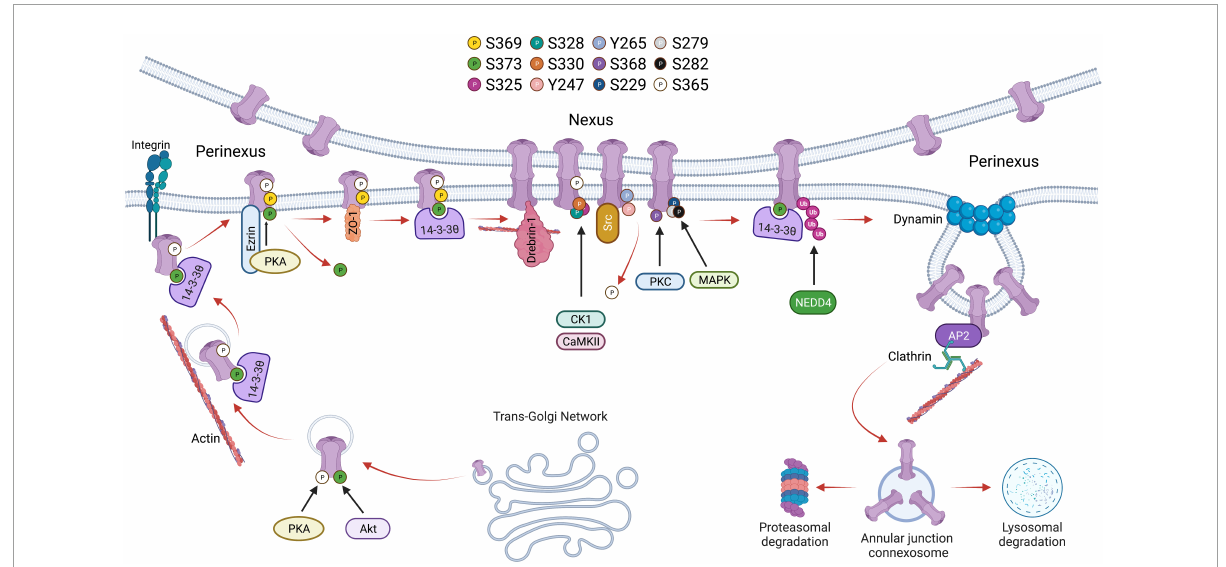
FIGURE1 Schematic showing the life cycle of Cx43 beginning from trafficking through trans -Golgi network to accrual at the perinexus followed by gap junction activity at the nexus and degradation through endocytosis followed by proteasomal or lysosomal degradation. Phosphorylation of various serine residues in Cx43 is